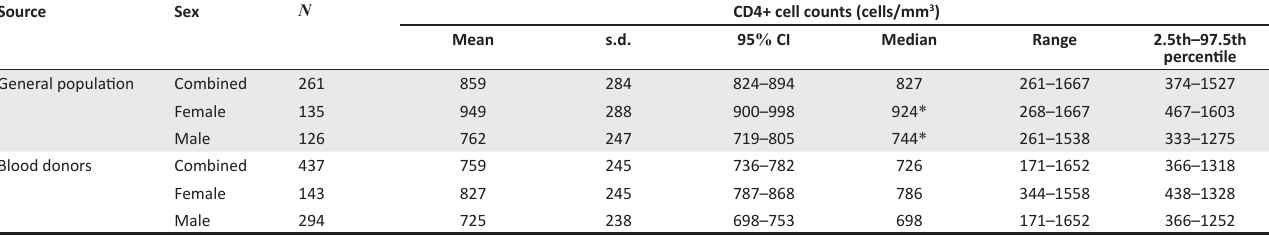
TABLE 1: CD4+ cell counts for healthy HIV-negative adults in Botswana.